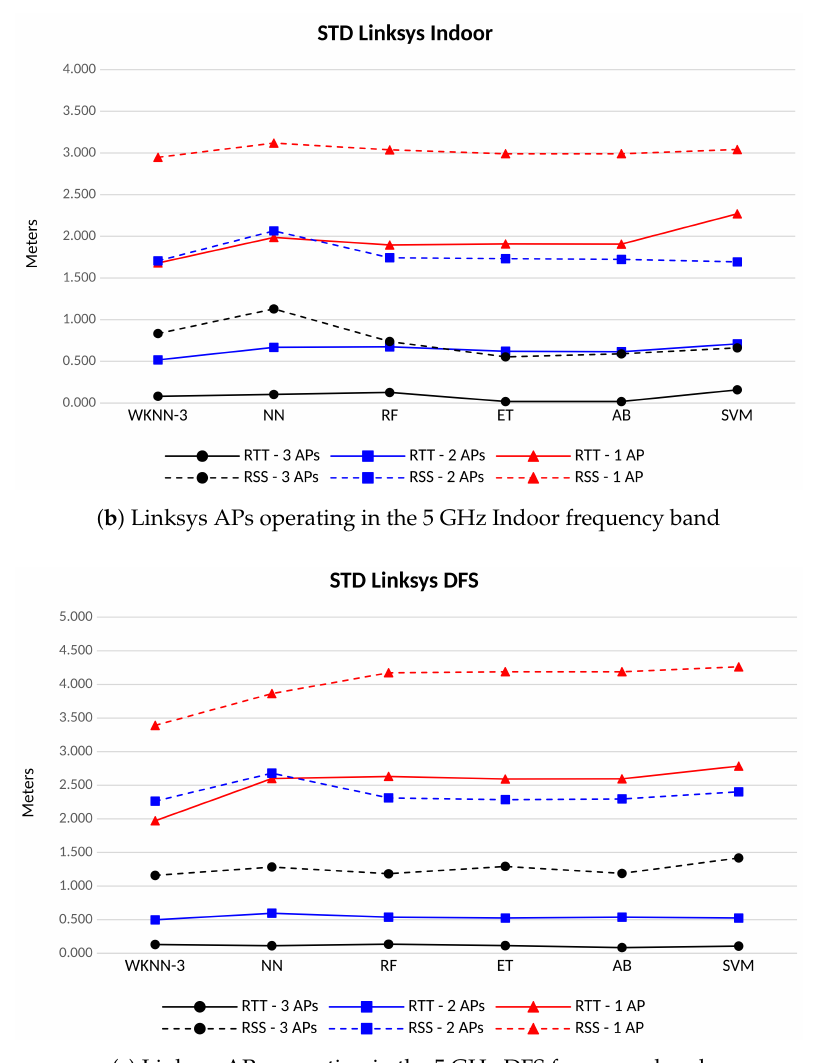
Figure 13. Standard deviation of the positioning error for different ML algorithms and number of APs of the same vendor and channel. FTM-based in solid lines, RSS-based in dashed